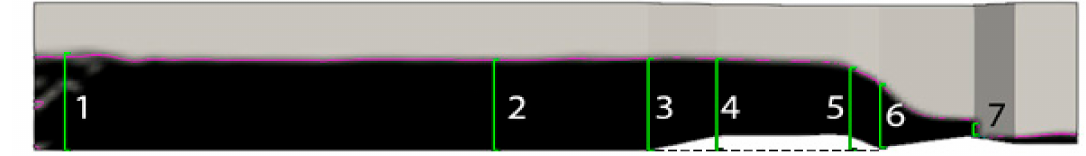
Figure 7. Location of cross-sections of Parshall